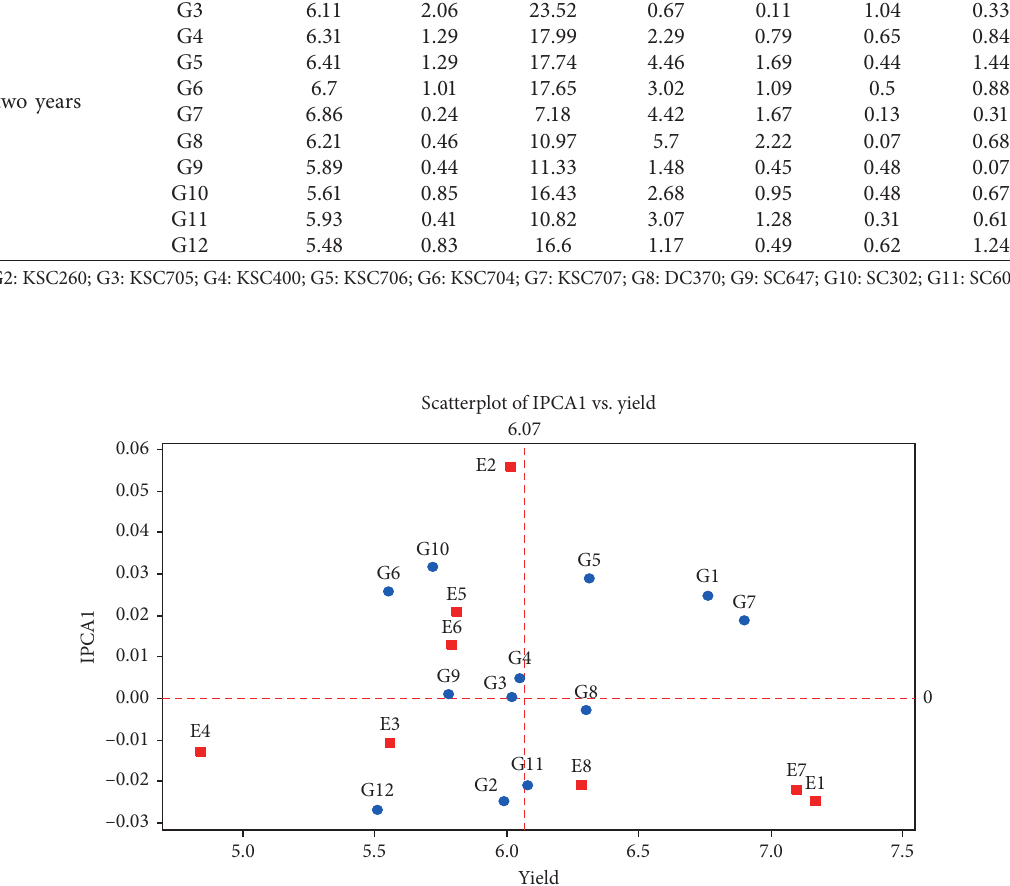
Figure 1: AMMI 1 biplot for main effects vs. IPCA1 in 12 hybrids of Zea mays L. from eight environments. G1: KSC703; G2: KSC260; G3: KSC705; G4: KSC400; G5: KSC706; G6: KSC704; G7: KSC707; G8: DC370; G9: SC647; G10: SC302; G11: SC604; G12: SC301. E1: Karaj